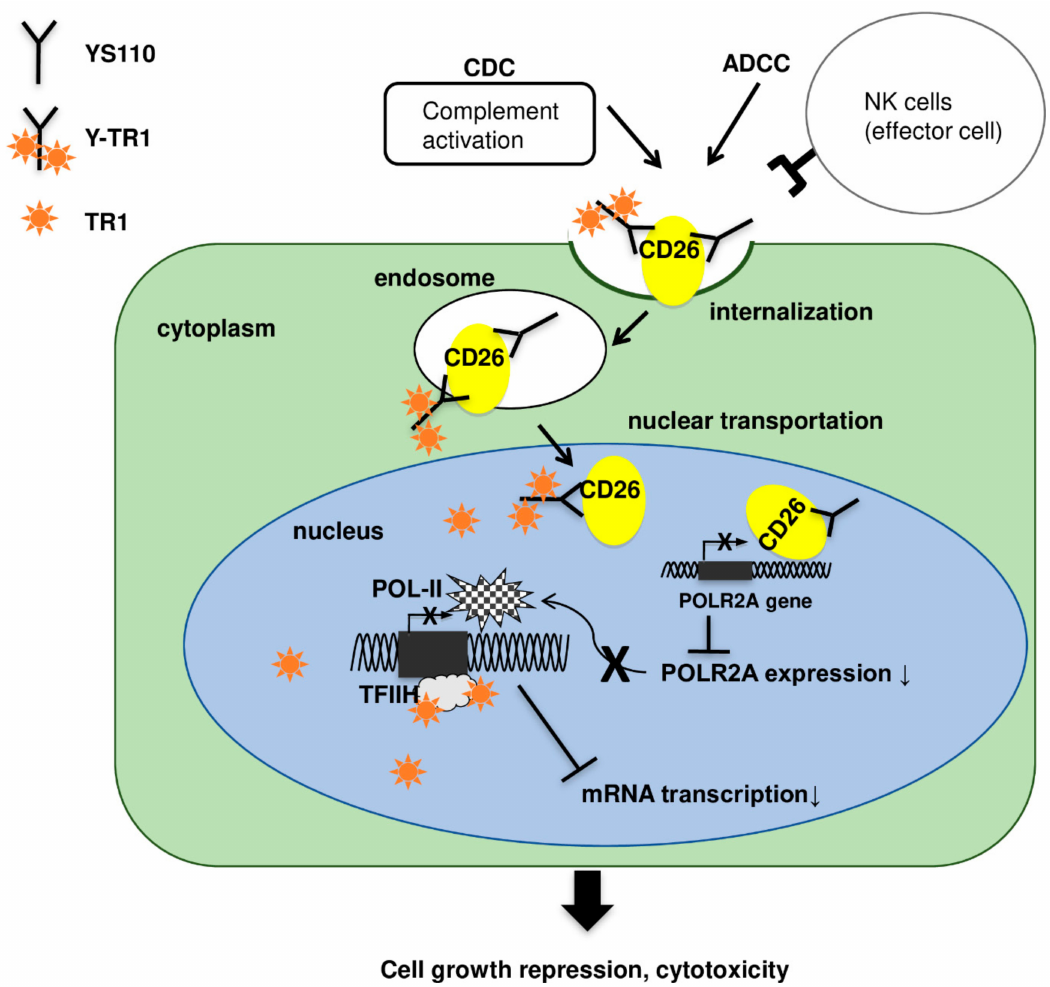
Figure 8. Y-TR1 has multiple anti-tumor e ff ects as follows; (1) introduction of cell death via immunological cytotoxicity such as antibody-dependent cell-mediated cytotoxicity (ADCC) and / or complement-dependent cytotoxicity (CDC), (2) retarded cell cycling of both G1 / S and G2 / M, (3) suppression of POLR2A transcription by increased amount of intranuclear CD26, (4) inhibition of TFIIH by TR1 carried into the nucleus using conjugation of TR1 to